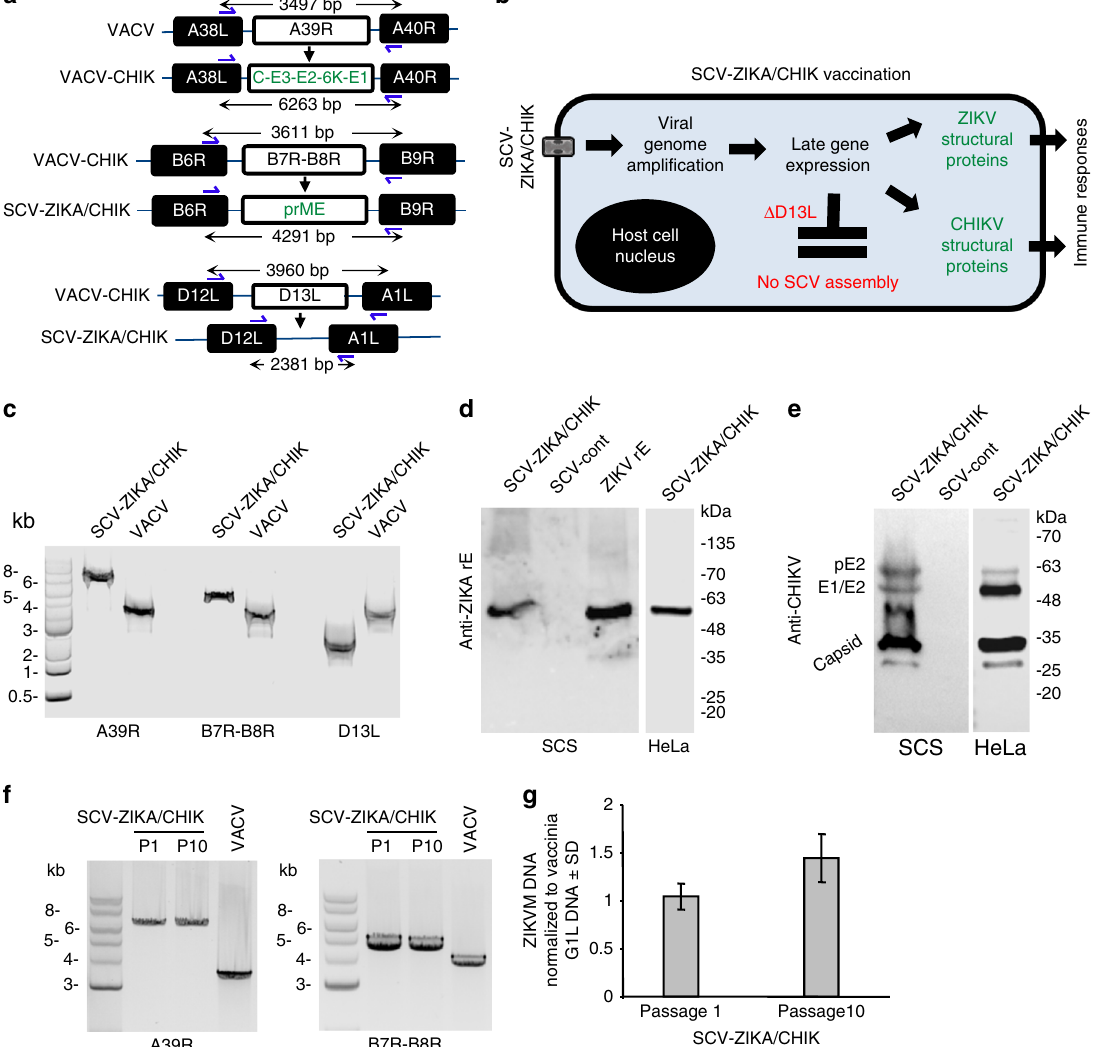
Fig. 1 SCV-ZIKA/CHIK construction, rationale and characterization. a VACV-CHIK was generated from vaccinia virus (VACV) by insertion of the CHIKV structural protein expression cassette inserted into the A39R locus. SCV-ZIKA/CHIK was constructed from VACV-CHIK by insertion of ZIKV prME expression cassette into the B7R-B8R locus and concurrent deletion of D13L . b After vaccination the genome is ampli fi ed in SCV-ZIKA/CHIK-infected host cells and CHIKV and ZIKV immunogens are expressed from the ampli fi ed genomes. Due to the targeted deletion of D13L , no viral progeny are generated. c PCR of SCV-ZIKA/CHIK and VACV infected SCS cells con fi rming insertion of CHIKV and ZIKV genes into A39R and B7R-B8R loci, respectively, and deletion of D13L . d Immunoblot of SCV-ZIKA/CHIK and SCV-cont infected SCS and HeLa cells using an anti-ZIKV E antibody, with recombinant ZIKV E (rE) as a positive control. e Immunoblot of SCV-ZIKA/CHIK and SCV-cont infected SCS and HeLa cells using a polyclonal anti-CHIKV mouse anti-serum. f Lysates of SCV-ZIKA/CHIK-infected cells after one (P1) and ten passages (P10) in SCS cells, were analyzed by PCR (as in c ) for retention of inserts in the A39R and B7R-B8R loci. g Quantitative PCR of ZIKV M DNA of lysates described in f , normalized to VACV G1L DNA. Error bars represent standard deviation ( n =